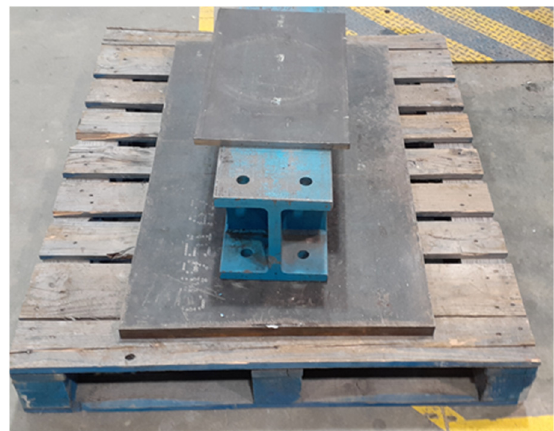
Figure 3. Artificial mass, placed on the test specimen.